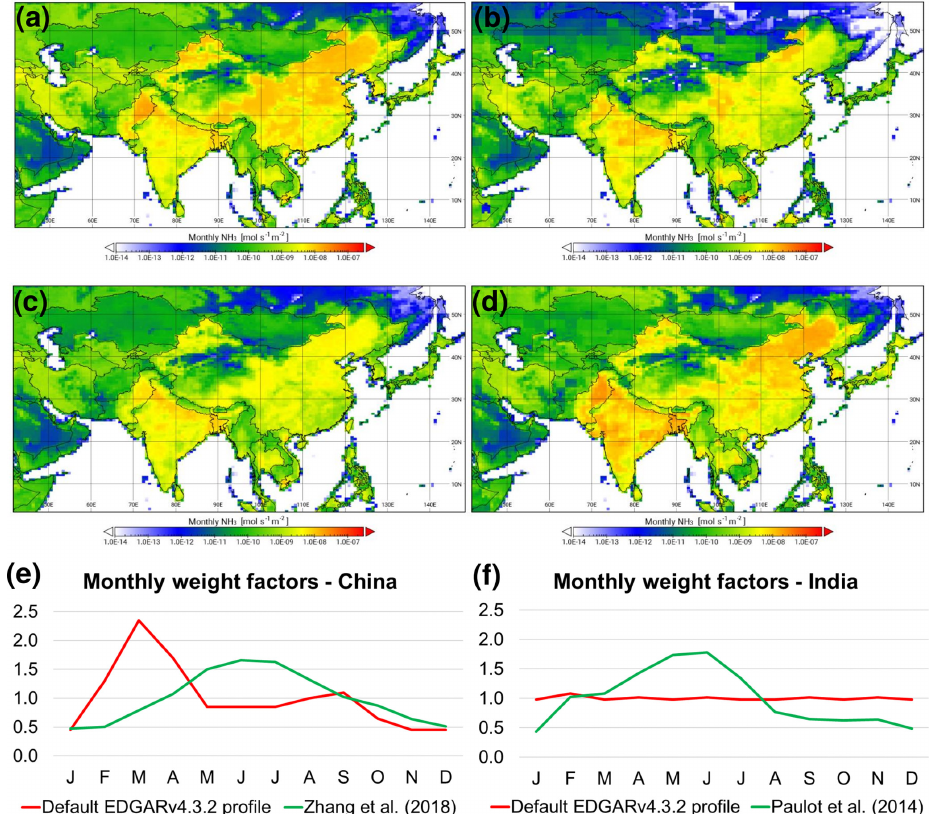
Figure 6. Monthly NH3 agricultural soil emissions (mols − 1 m − 2 ) estimated with HERMESv3_GR in east Asia (0 . 5 ◦ × 0 . 7 ◦ ) for March and June using the default temporal profiles reported by EDGARv4.3.2 (a, c) and a gridded temporal profile derived from the works of Paulot et al. (2014) and Zhang et al. (2018) (b, d) , and monthly weight factors obtained in China and India for each case (e, f)